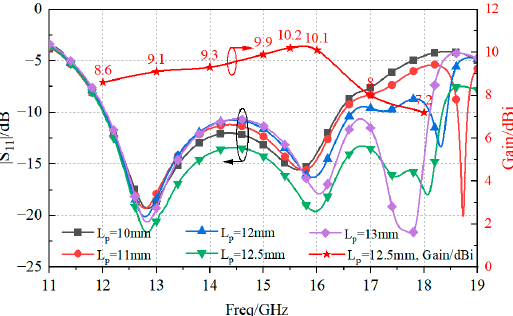
Figure 7. Numerical analysis of the magnitude of the reflection coefficient and peak gain versus Lp